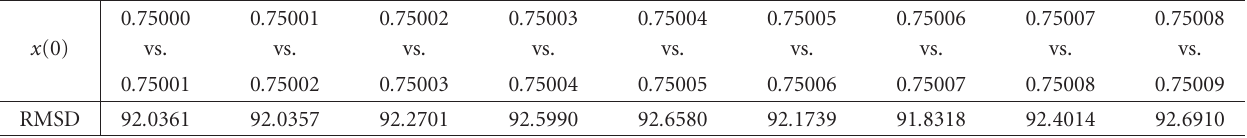
Table 4: The RMSD between the encryption results with µ = 3 . 9 and tiny fluctuation of 10 − 5 in x